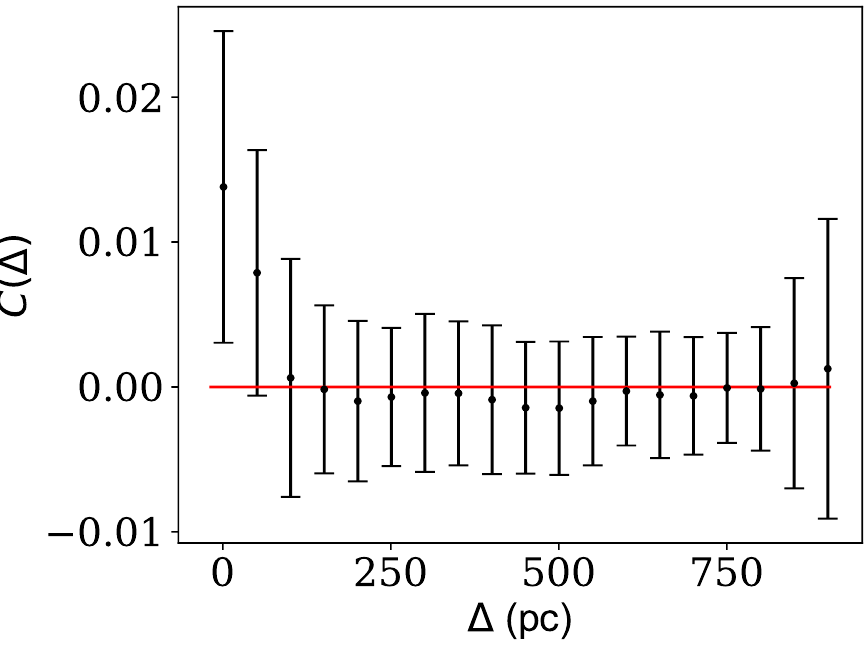
Figure 3. The two-point correlations C ( ∆ ) between DM mass density fluctuations as a function of the distance between the position of mass densities ∆ in the Fornax dSph. Correlations at ∆ < 100 (pc) are induced by the kernel density estimator and are not genuine. We observe no statistically significant correlation at larger distances in the